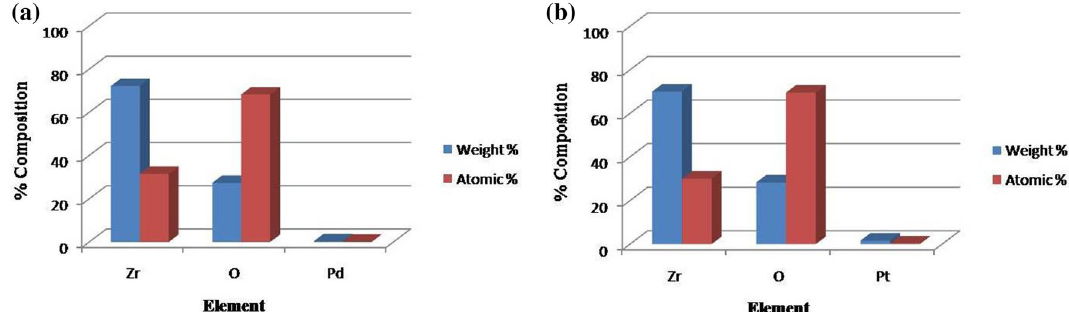
Fig. 2 EDX study of a Pd/ZrO